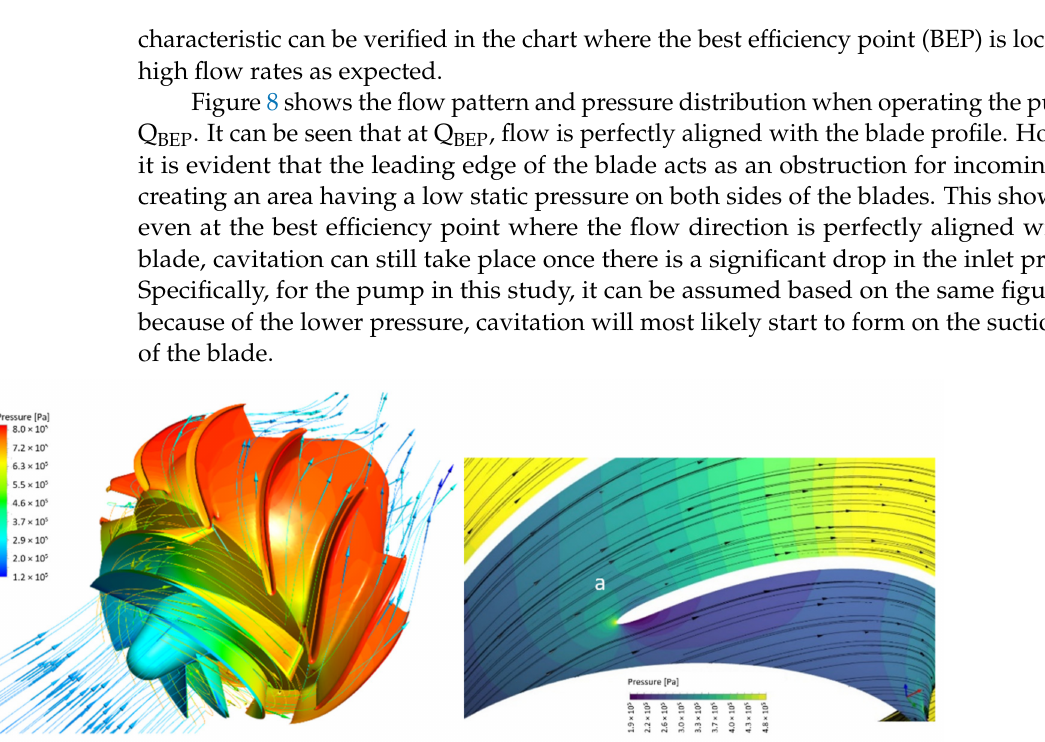
Figure 8. Velocity streamlines and pressure distribution at Q BEP. Even when flow direction is perfectly aligned with the blade, the blockage effect (a) still exists on the blade tip causing a decrease in pressure on both sides of the impeller